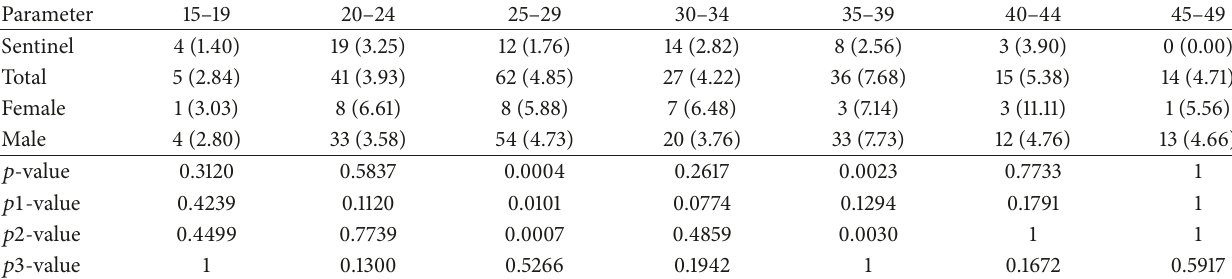
Table 5: Distribution of five-year burden of HIV infection by age categories.